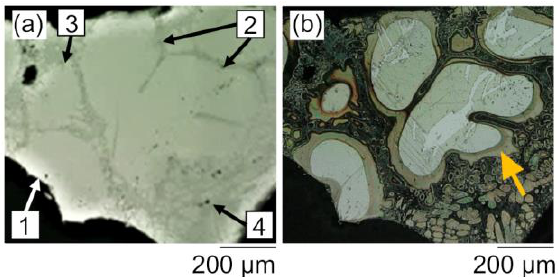
Figure 7. Microscopic images of cross section of the aluminum alloy foam. ( a ) Original images of six specimens, ( b ) processed image after filling primary crystals with red, and ( c ) the magnified view of the lower-left part in ( b ).